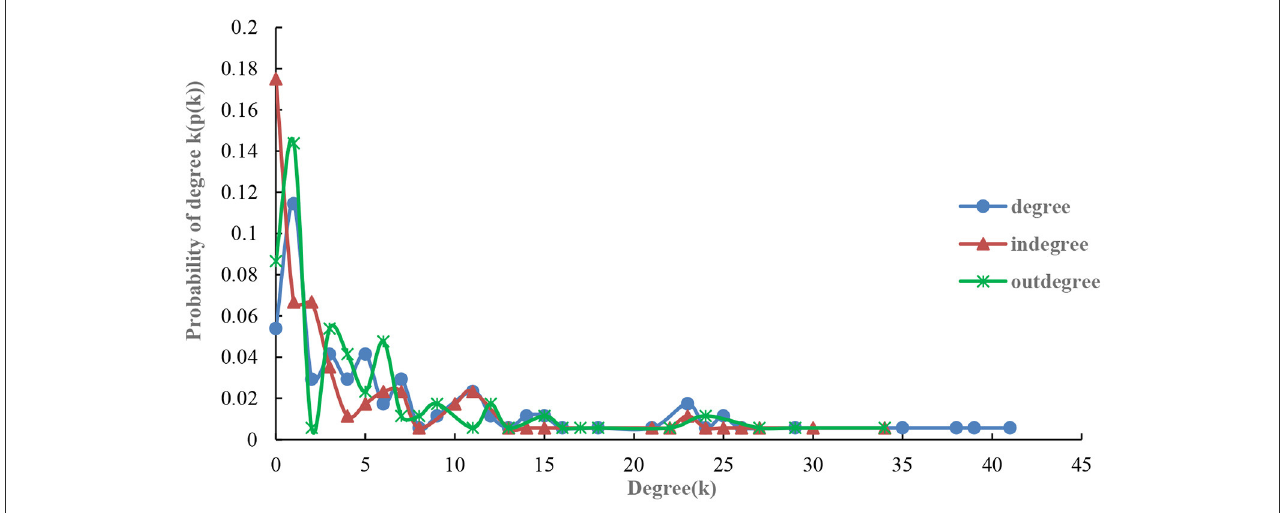
FIGURE2 Exponential probability distribution for the degree, in-degree, and out-degree of the import volumes of agricultural products in